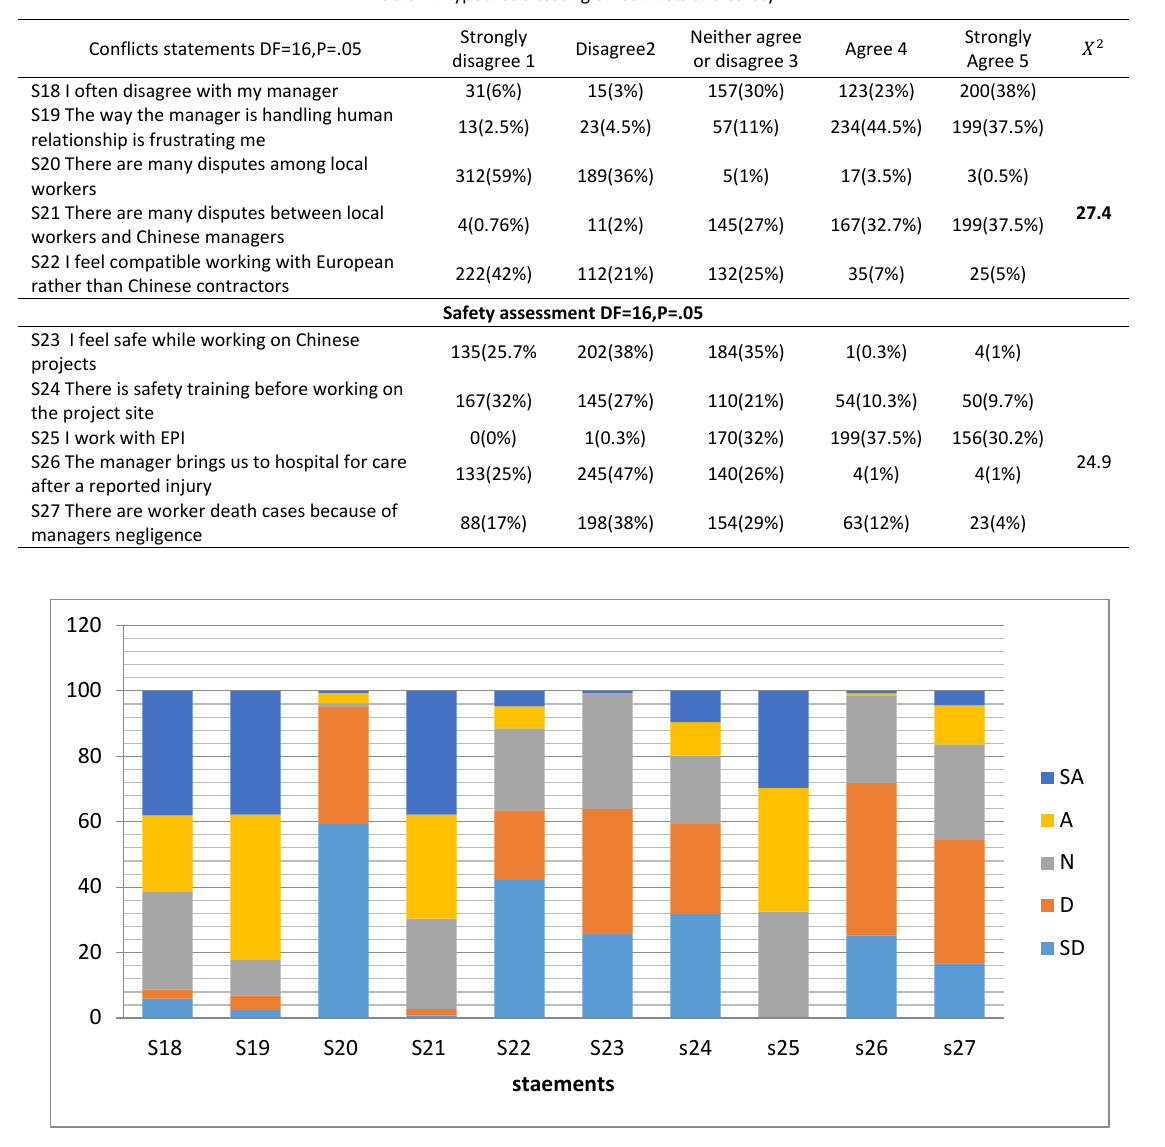
Fig. 4: local workers agreement level on conflicts and safety statements